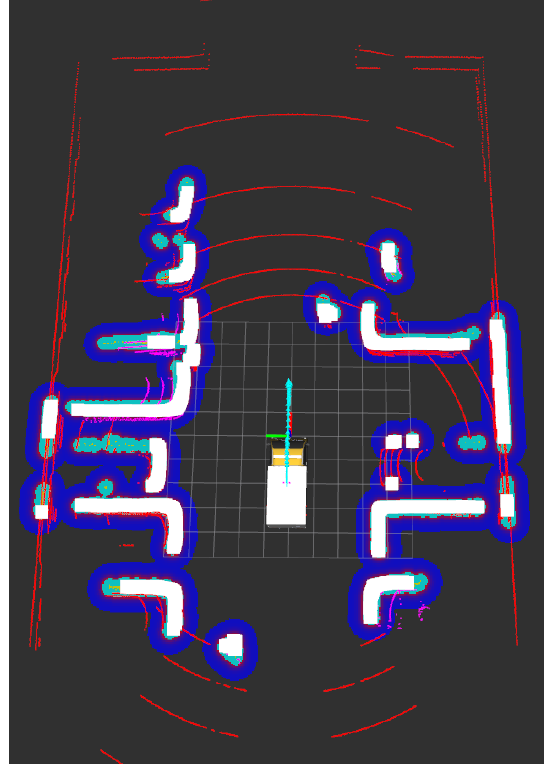
Figure 7. Data from the LiDAR sensor placed on the top of the AV. The odometry and mapping data are shown for the parking scenario; this is based on LOAM Velodyne ROS package shown in Figure 4. The pedestrians and the parked vehicles around have been detected and the system adds an inflation layer for extra protection from